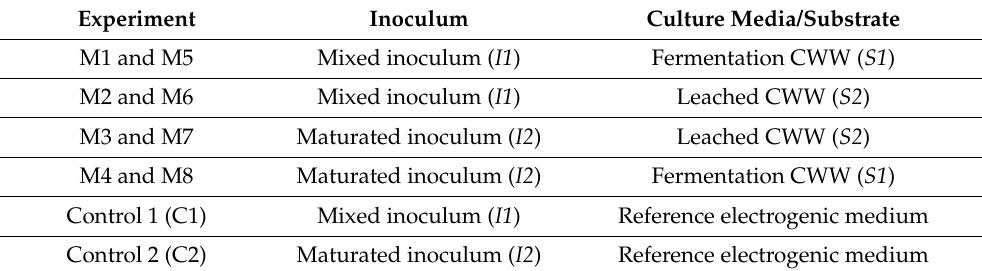
Table 1. Experimental design.